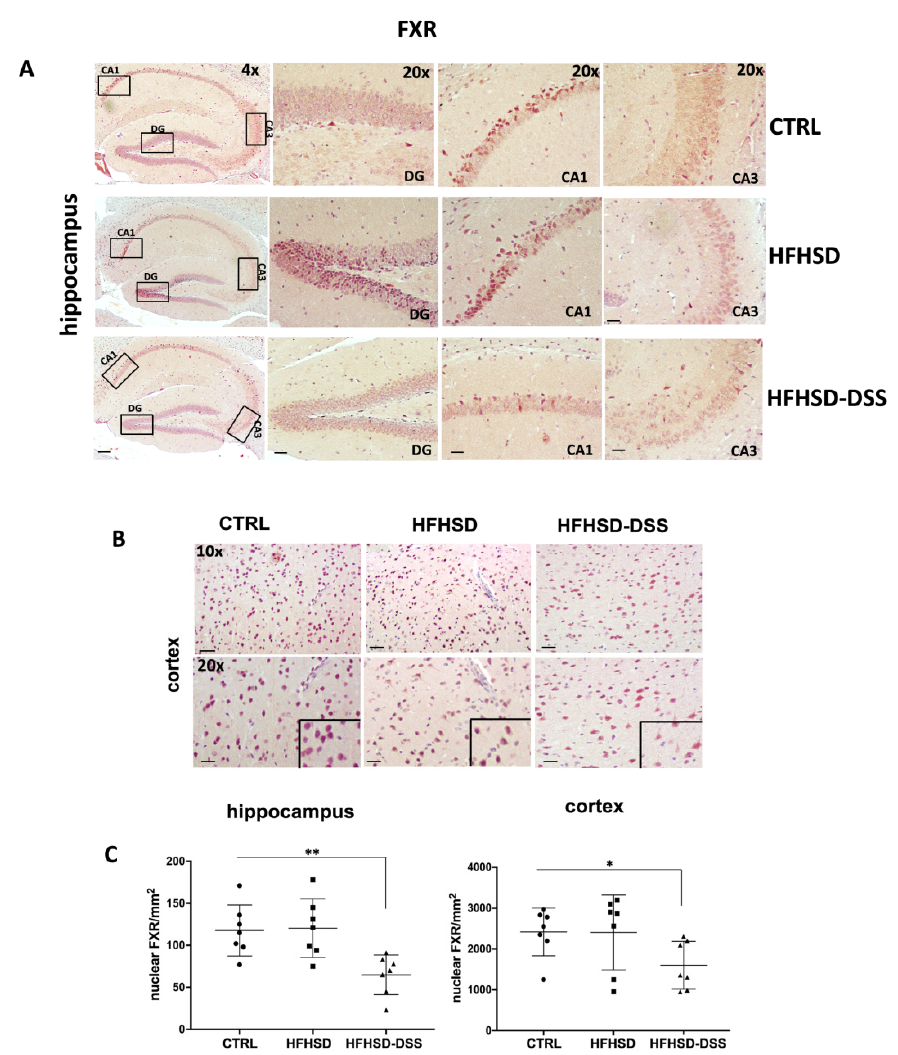
Figure 3. Representative images of immunohistochemistry (IHC) staining of FXR in different regions of hippocampus ( A ) and in frontal cortex ( B ) displaying expression and nuclear localization of FXR. 20× magnification: scale bar = 25 μ m. 10x magnification: scale bar = 50 μ m. 4 × magnification: scale bar 100 µ m; Quantitative analysis of FXR expressing nuclei /mm 2 in both brain districts ( C ). Mean ± SD for each group is shown. Statistical significance: * p < 0.05; ** p < 0.01.